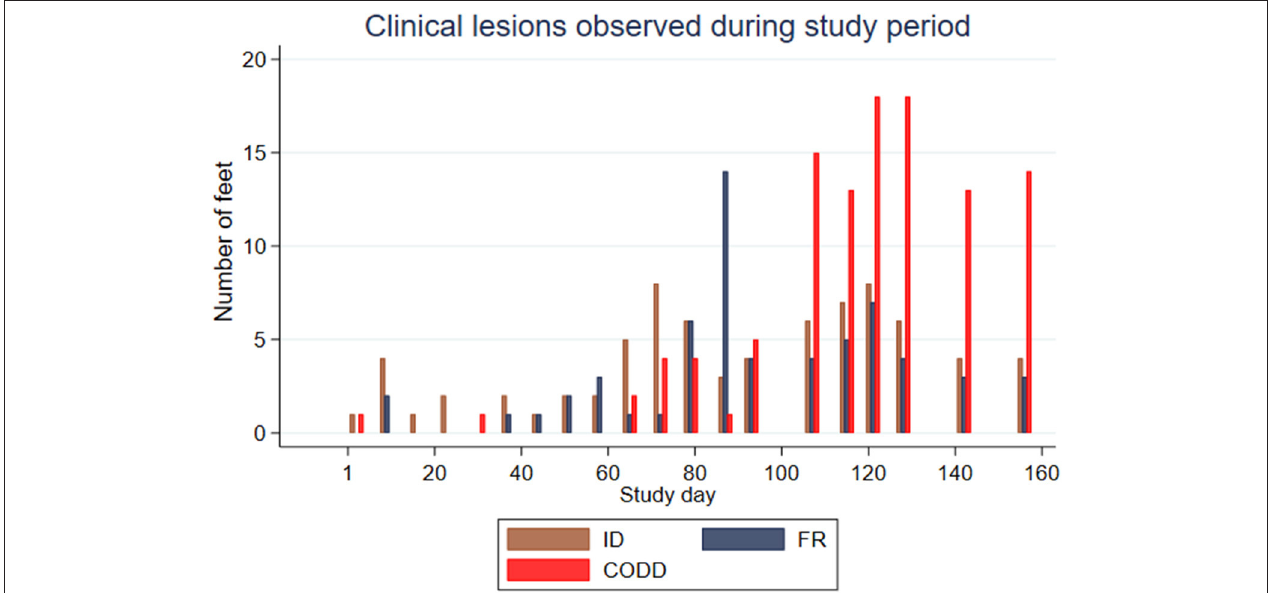
(3.64% of recordings), FR (2.68% of recordings), CODD (5.85% of recordings), and other lesions (1.55% of